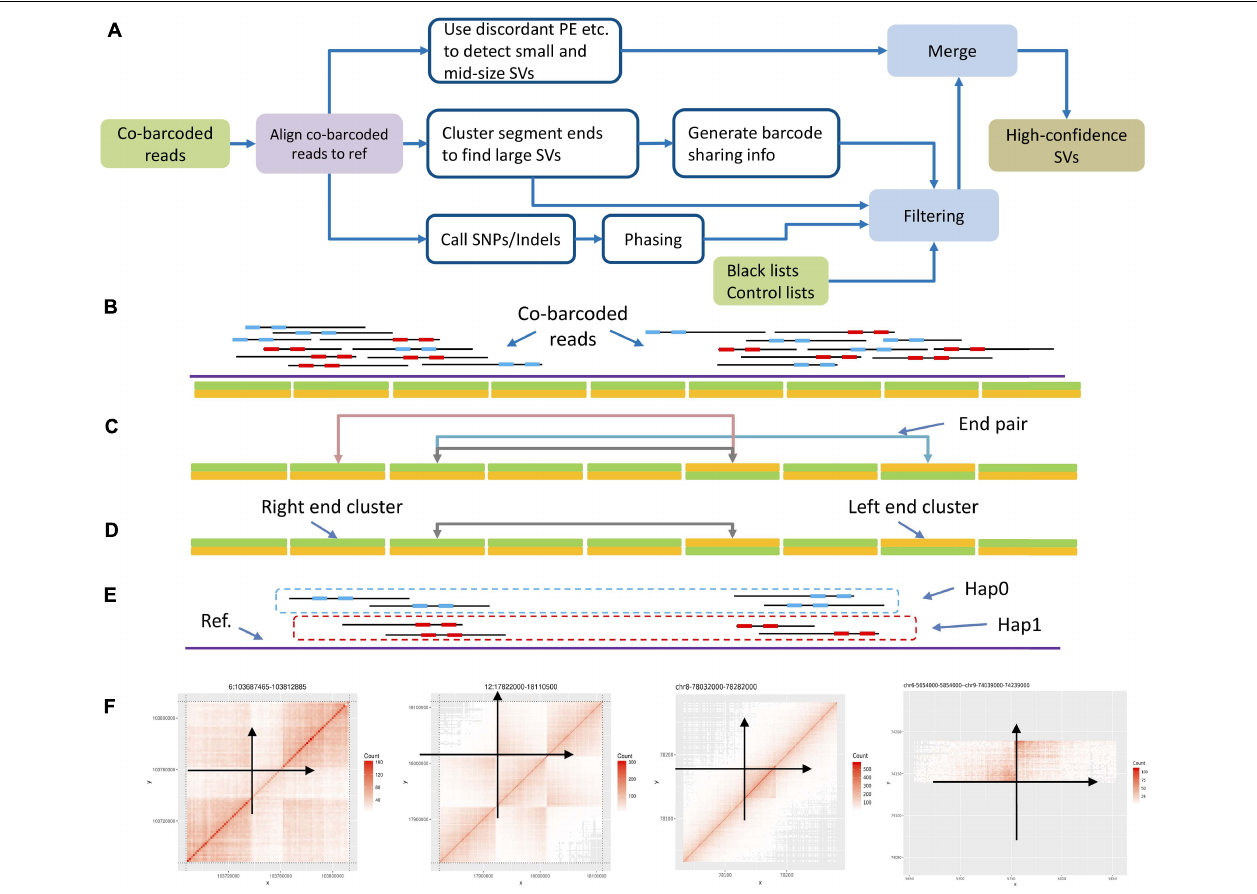
FIGURE 2 | Workflow and algorithm. (A) Structural variation detection workflow. (B) Cluster segment ends by bins: left end cluster and right end cluster. (C) Pair up ends by shared barcodes. (D) Pair down candidates by removing those nearby. (E) Split into haplotypes by phasing barcodes on phasing blocks. (F) Use barcode sharing heatmap pattern as a filter, and anchor the variation on the genome. Each point in the heatmap represents the shared barcode number at the corresponding X -axis and Y -axis positions by color